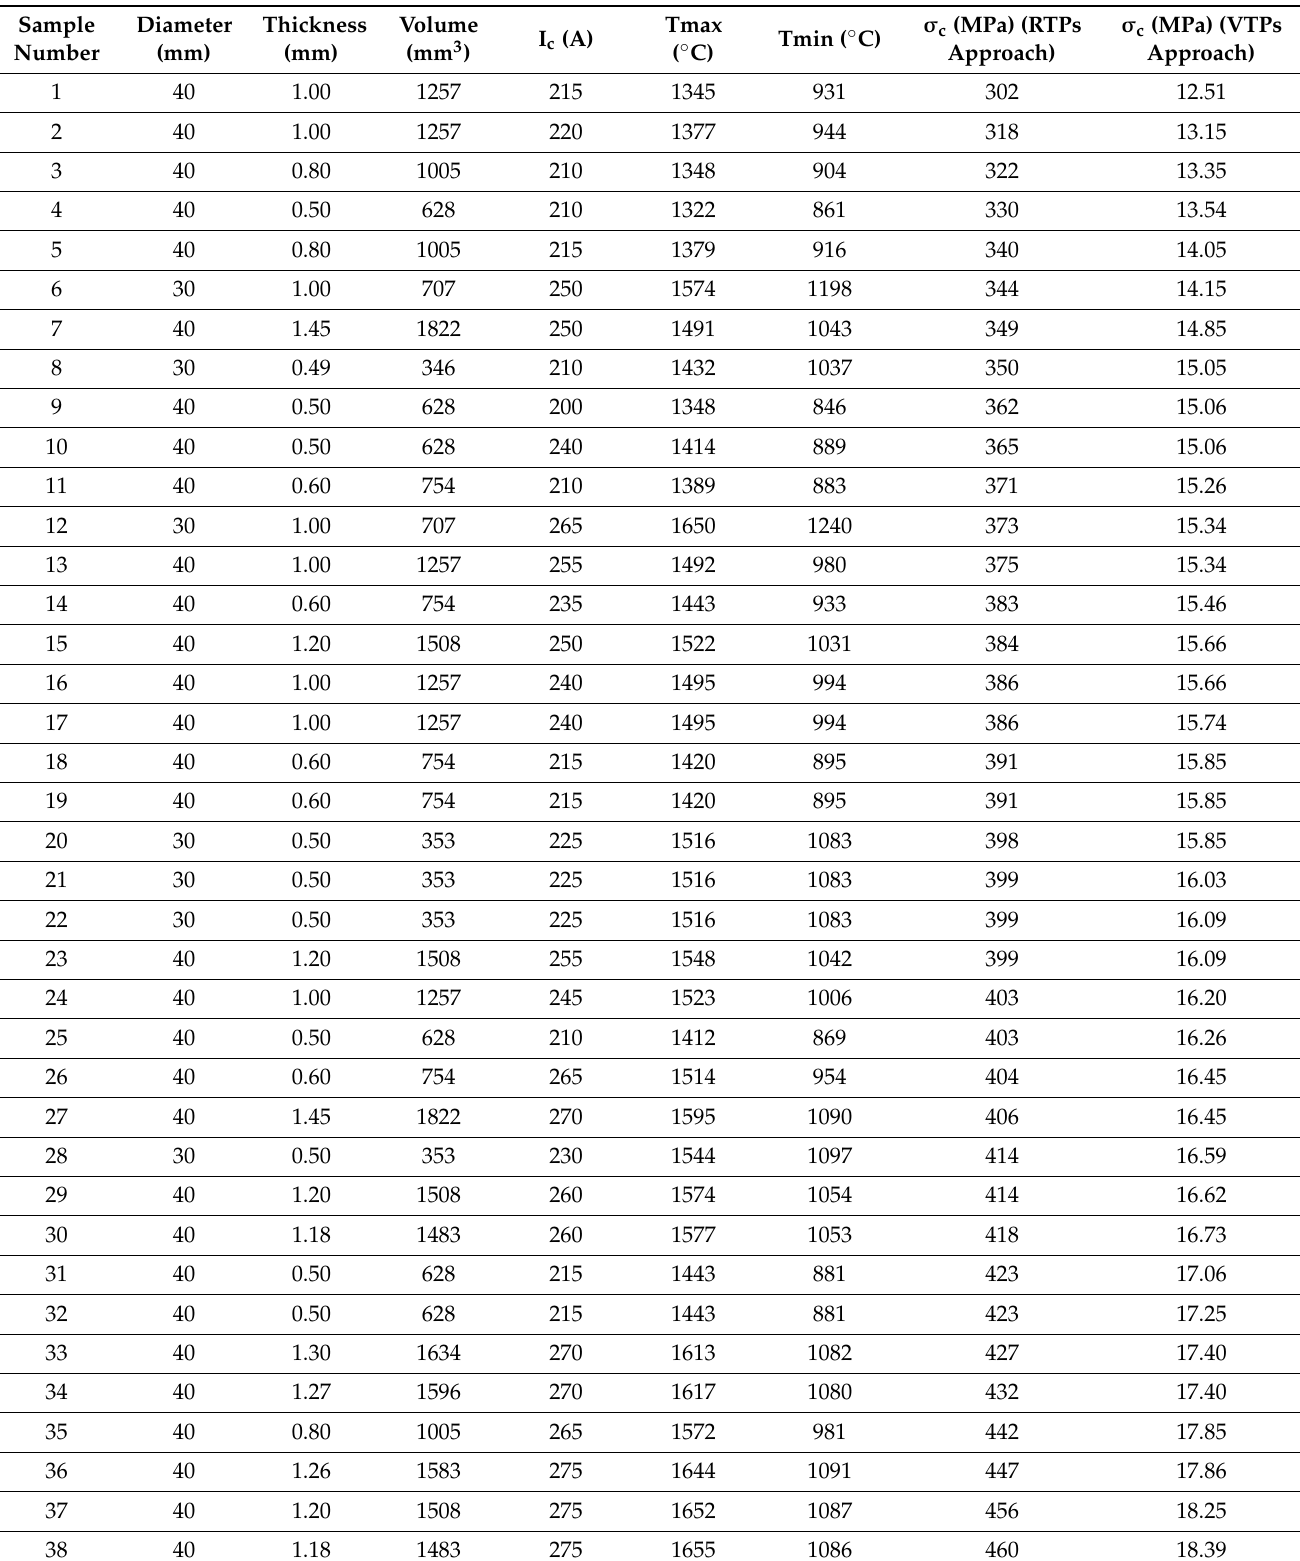
Table 4. SiC SA input data for Weibull statistical